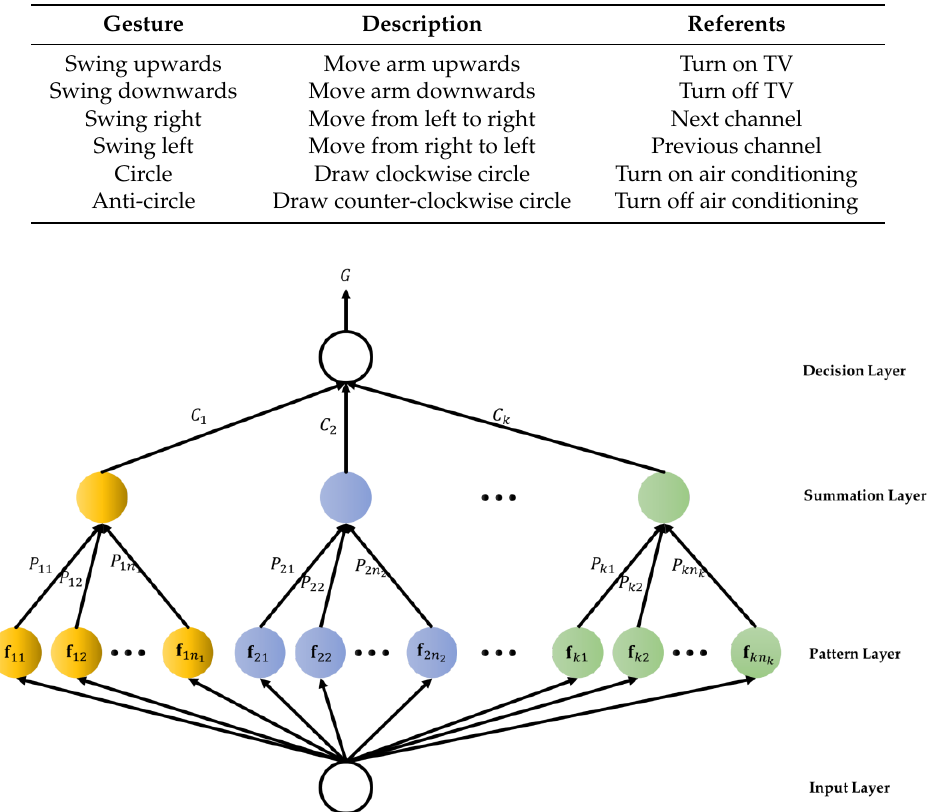
Table 1. Gesture-referent mapping.